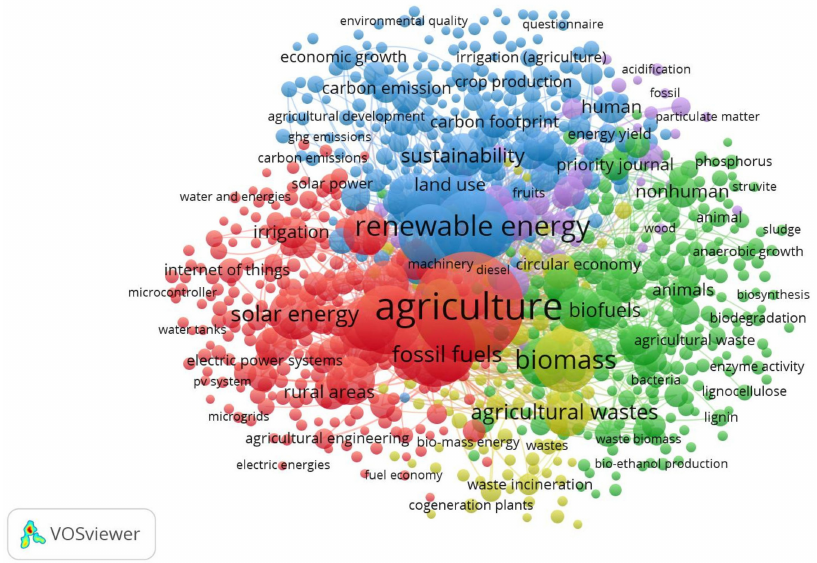
Figure 10. Analysis of the co-occurrence of